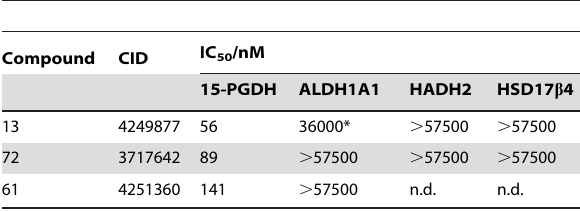
Table 3. Selectivity profiling of key inhibitors against